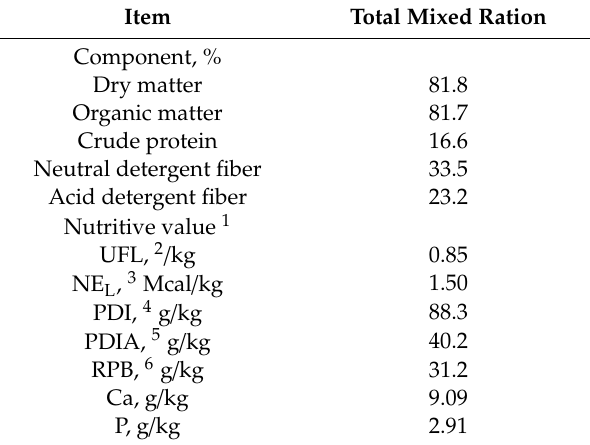
Table 1. Chemical composition and nutritive value (dry matter basis) of the ration. Item Total Mixed Ration Component,